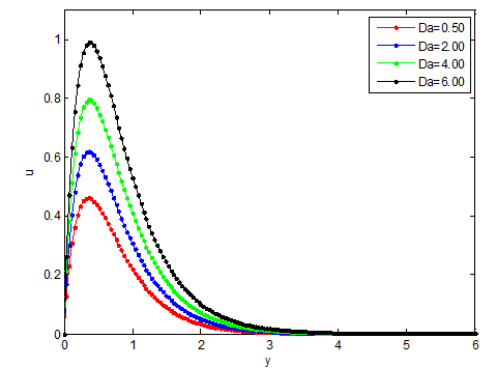
Figure 18. Effects of Darcy number on the concentration distribution